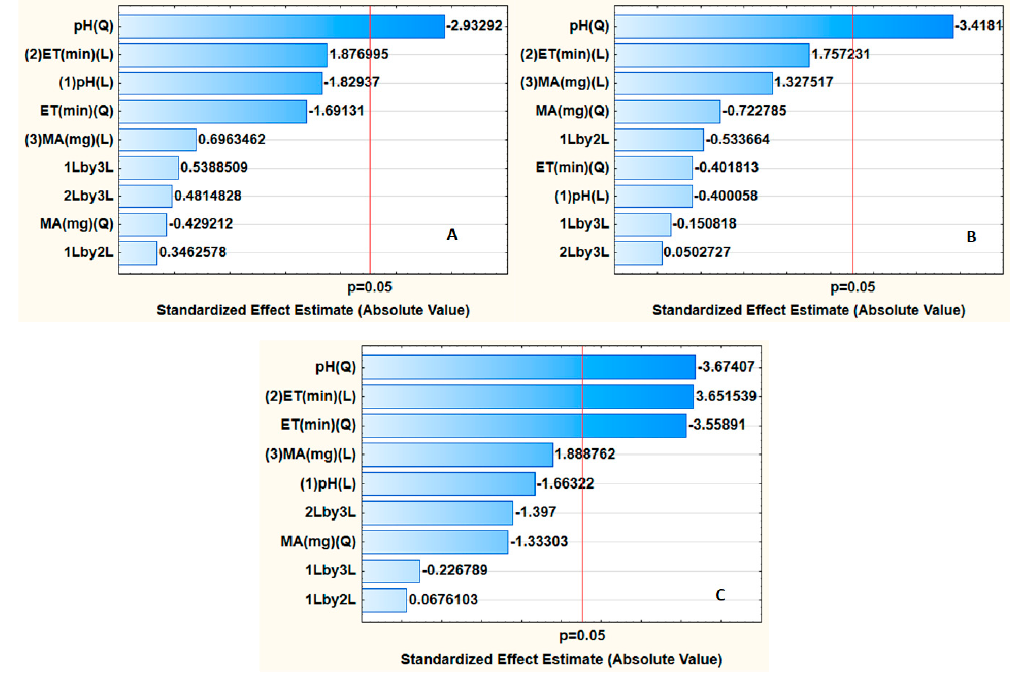
Figure 2. Pareto chart for standardized effects on variables for preconcentration of ( A ) β -blockers and anticonvulsants, ( B ) fluoroquinolones and ( C ) parabens.